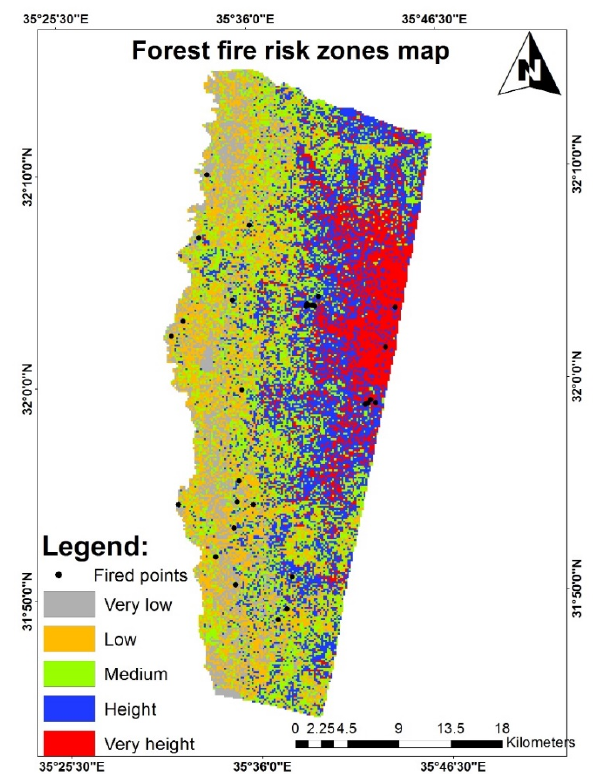
Fig. 8. Thematic map of the forest fire vulnerable